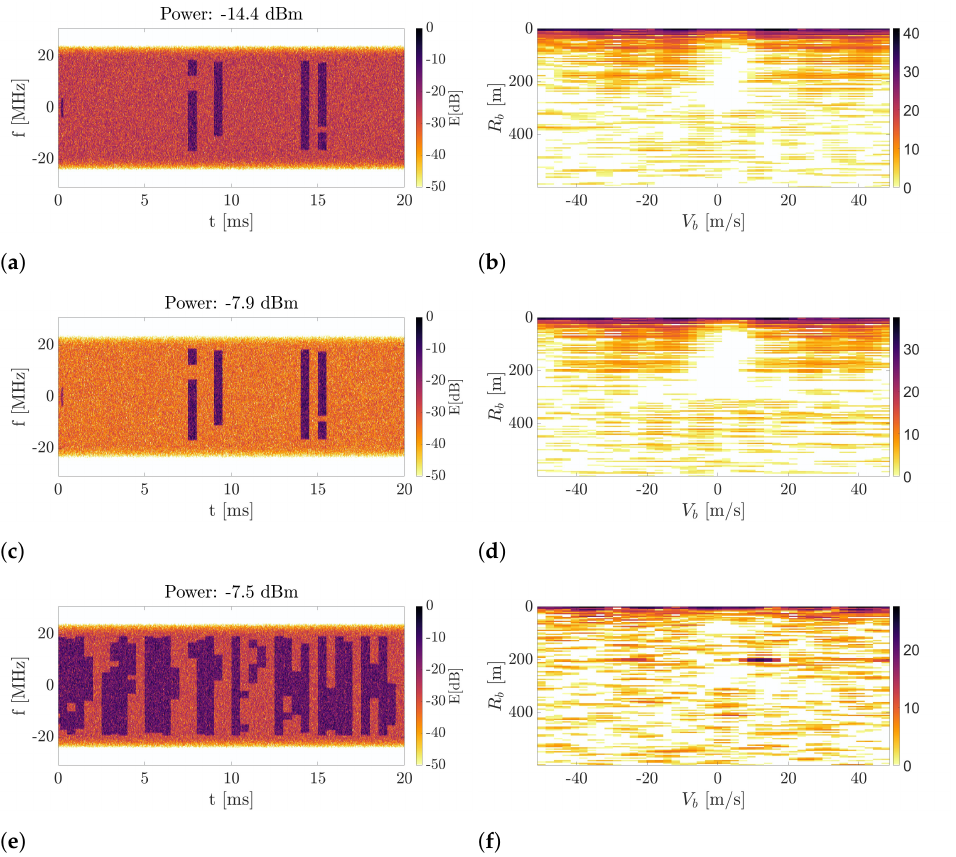
Figure 10. Evaluation of power measurement method. Spectrograms and CAF plots for different amount of content in real-life 5G signal. ( a ) Spectrogram for 10% of content filling. ( b ) CAF for 10% of content filling. ( c ) Spectrogram for 10% of content filling with larger transmission power. ( d ) CAF for 10% of content filling with larger transmission power. ( e ) Spectrogram for 70% content filling. ( f ) CAF for 70% content